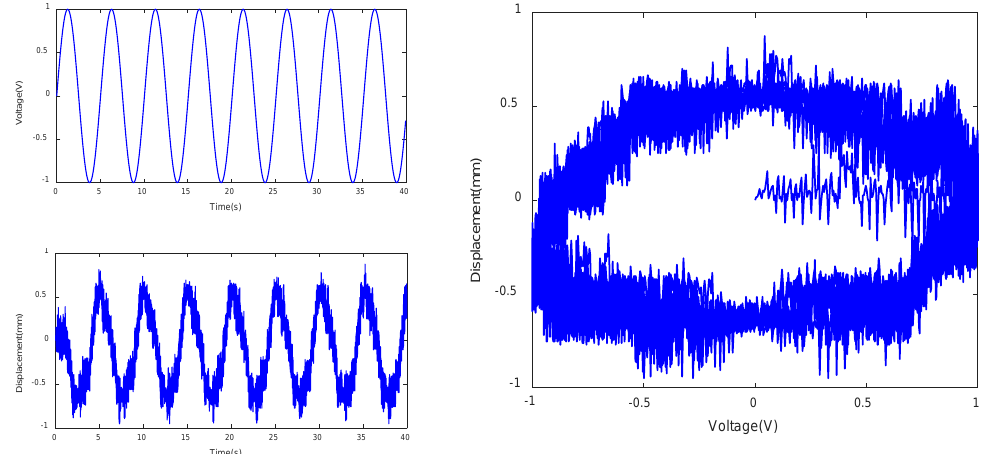
Figure 4. Tip displacement at actuating voltage with amplitude of 1V and frequency of 0.5/2 π Hz.